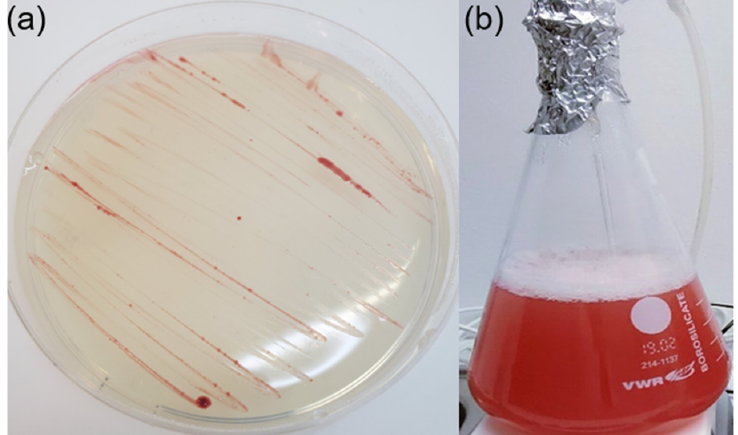
Figure 2. ( a ) Plates showing pure culture of Gemmatimonas phototrophica strain AP64 ( b ) and liquid culture of Gemmatimonas groenlandica strain TET16 (picture of TET16 is adapted from ref.